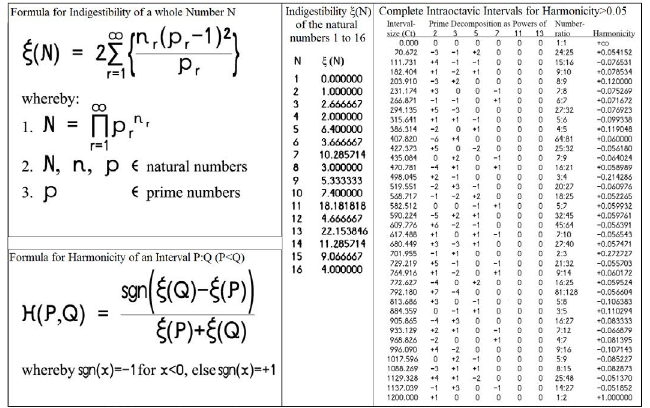
Figure 20: Formulae and Tables for Indigestibility (upper left) and Harmonicity (lower